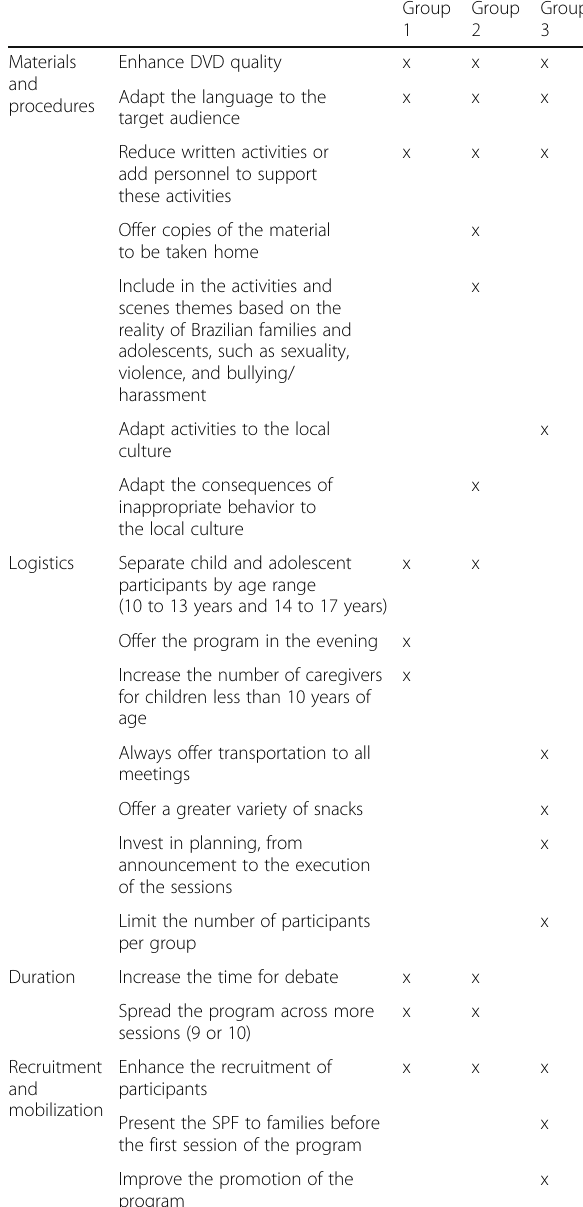
Table 1 Cultural adaptation recommendations according to the nominal groups of parents/guardians, adolescents, multipliers, facilitators, and